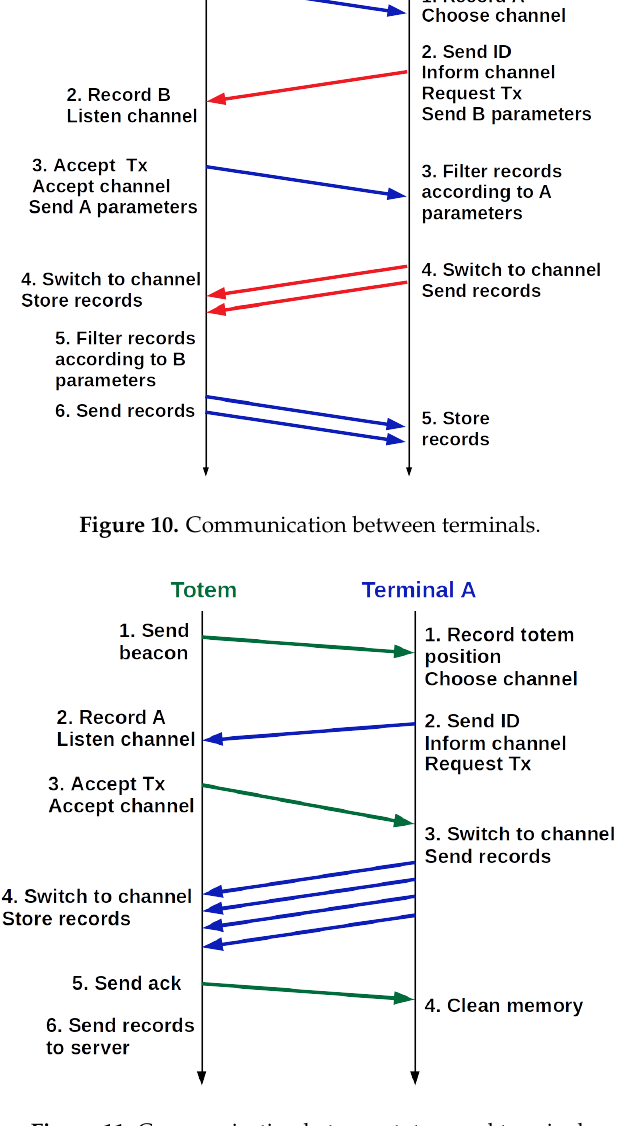
Figure 11. Communication between totem and